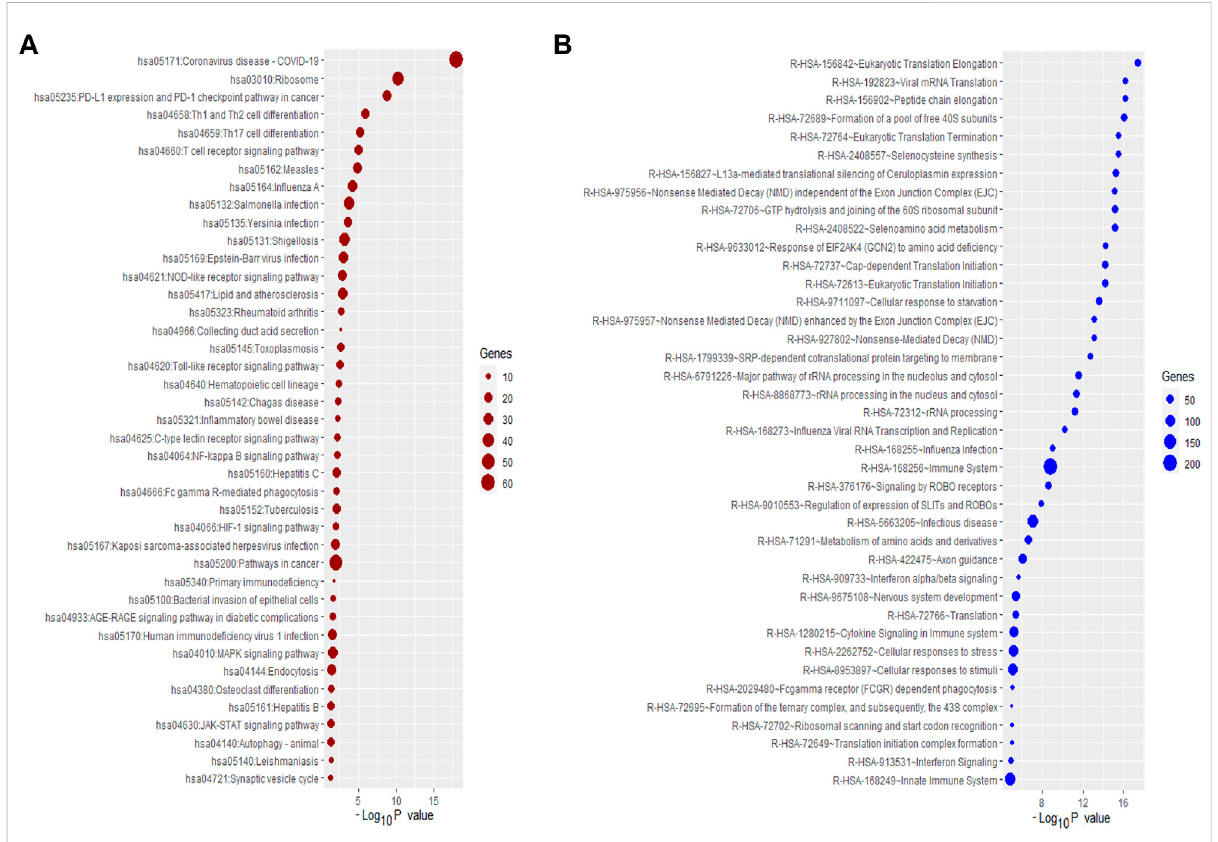
FIGURE 3 The Signi fi cantly enriched pathways associated with DEGs. (A) The enriched KEGG pathways. (B) The enriched some of the top Reactome